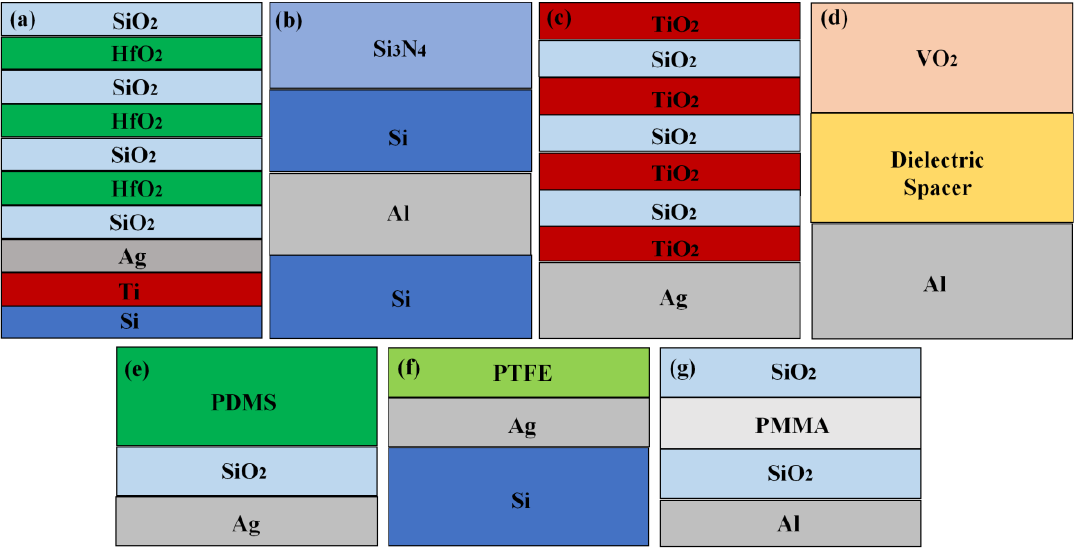
Figure 2. Schematics of various metamaterial film structures used for radiative cooling. Each design has a different layered structure: ( a ) HfO 2 /SiO 2 multi-layer on Ti [28], ( b ) Si 3 N 4 /Si/Al on Si [29], ( c ) SiO 2 /TiO 2 multi-layer on a metallic Al/Ag reflector [35], ( d ) VO 2 with a dielectric spacer on Al [37], ( e ) PDMS/SiO 2 on Ag [38], ( f ) PTFE/Ag on Si [39], and ( g ) SiO 2 /PMMA/SiO 2 on Al [40] have been reported.